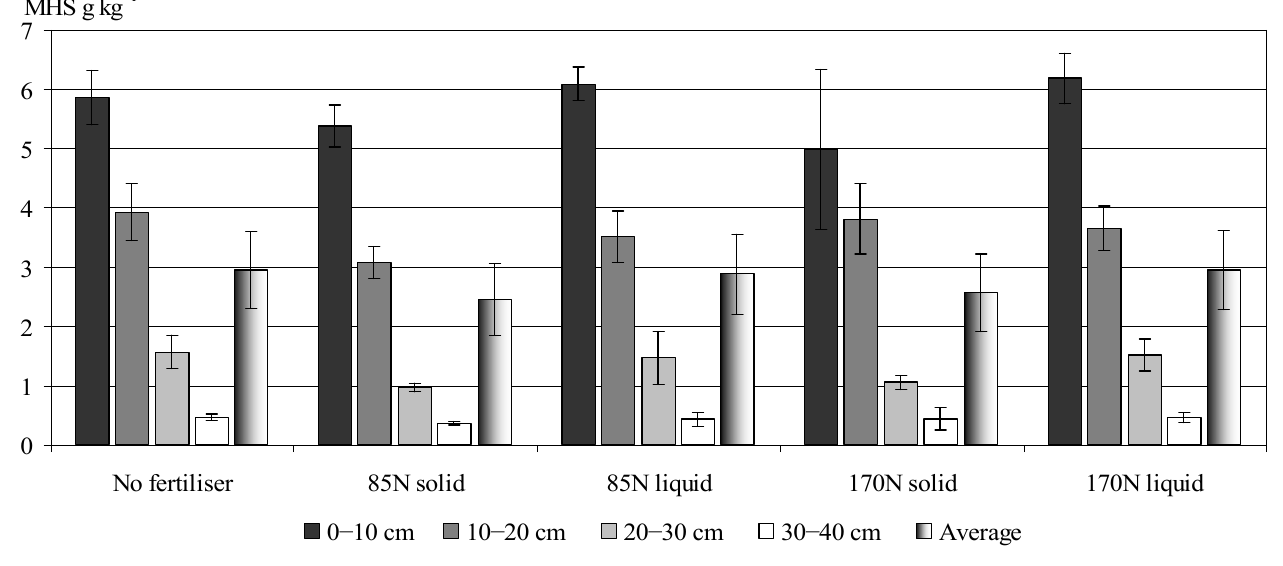
Figure 14. MHS content in the grassland in Fluvisol, 2020.